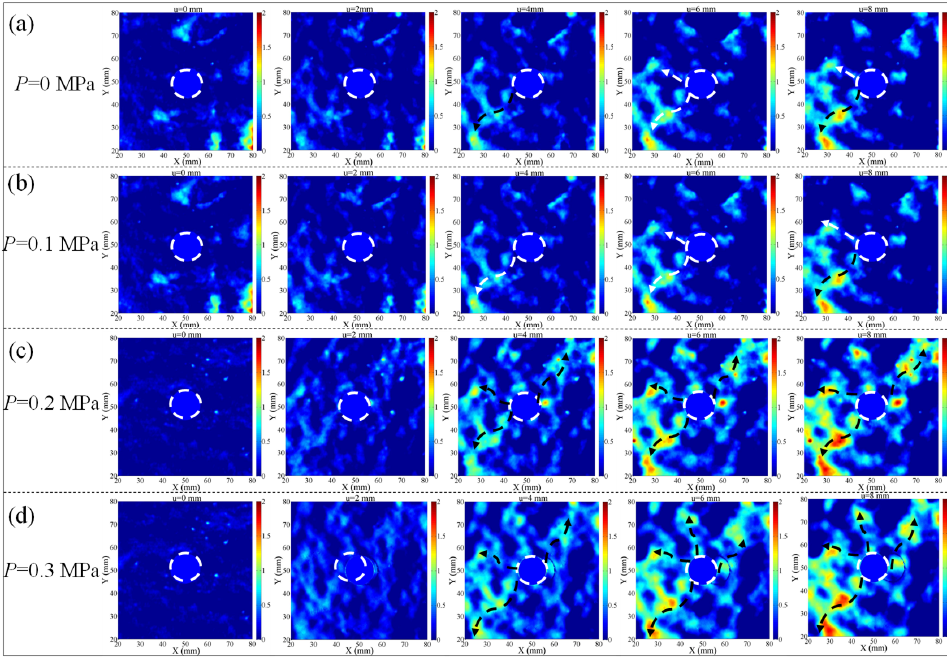
Figure 13. Aperture distribution under seepage water pressure are ( a ) 0 MPa, ( b ) 0.1 MPa, ( c ) 0.2 MPa, ( d ) 0.3 MPa.